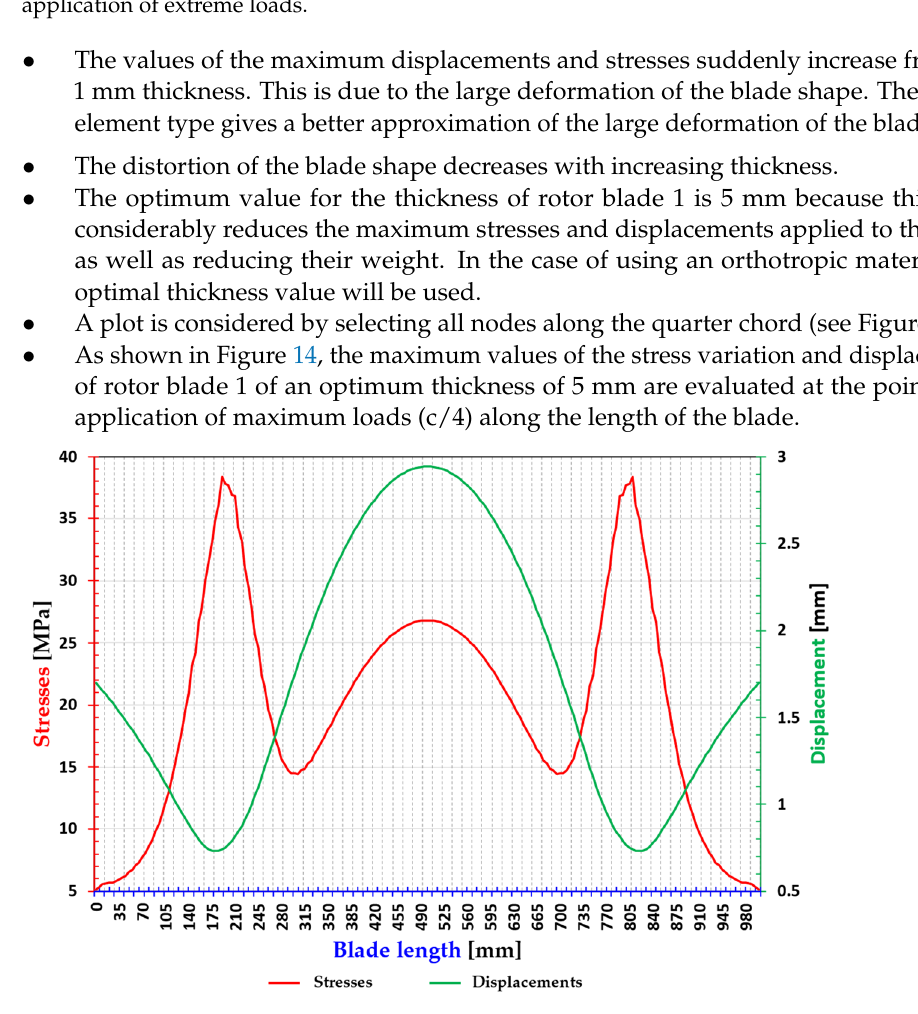
Figure 14. Maximum values of stresses and displacements at the point of application of the maximum loads (c/4) of the blade of rotor 1 in aluminum with the optimal thickness of 5 mm.